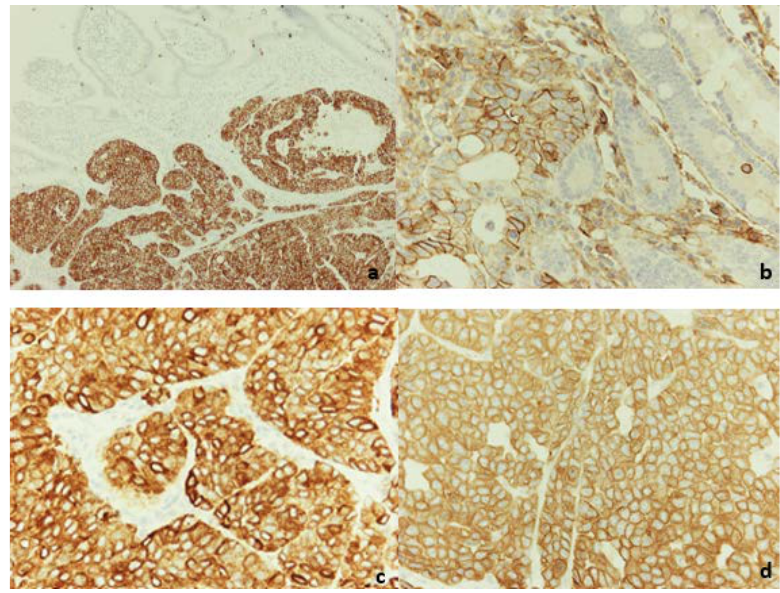
Figure 4. ( a ) Synaptophysin, 10×, ( b ) CD56, 40×, ( c ) EMA, 40×, ( d ) CK8/18, 40×.